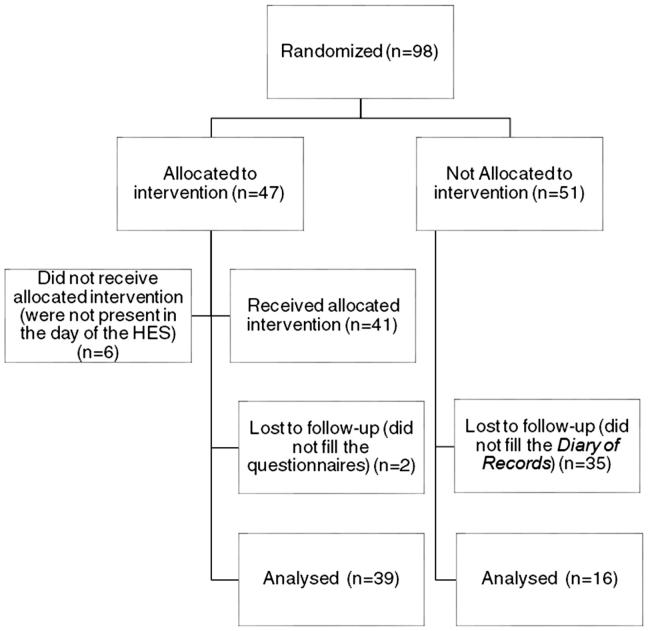
Participants diagram flow.